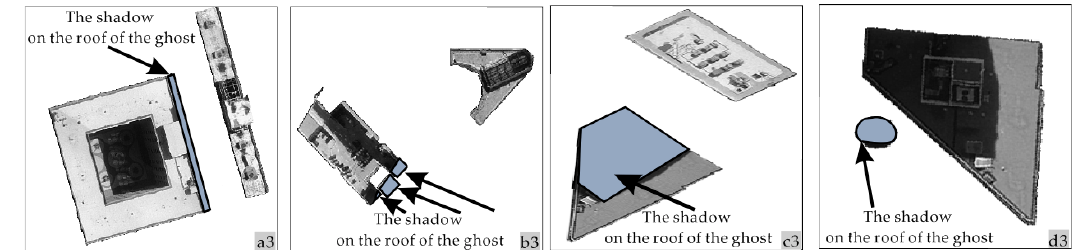
Figure 11. The shadows on the ghost roofs.